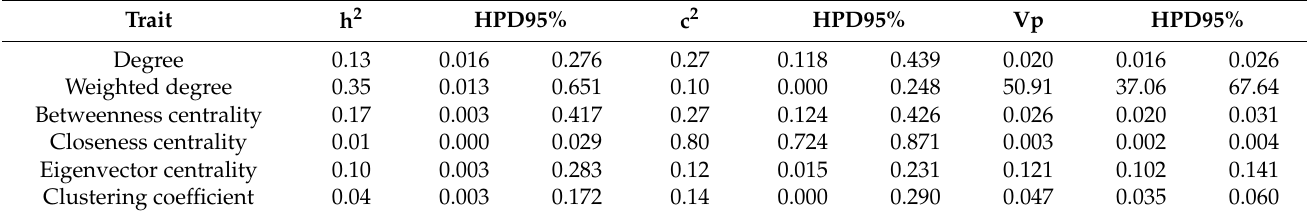
Table 3. Posterior means of heritability (h 2 ), the phenotypic proportions of the variance due to the environmental pen effects (c 2 ), the phenotypic variances (Vp), and the 95% highest posterior density intervals (HPD95%) for social network analysis traits for aggressive behaviour.